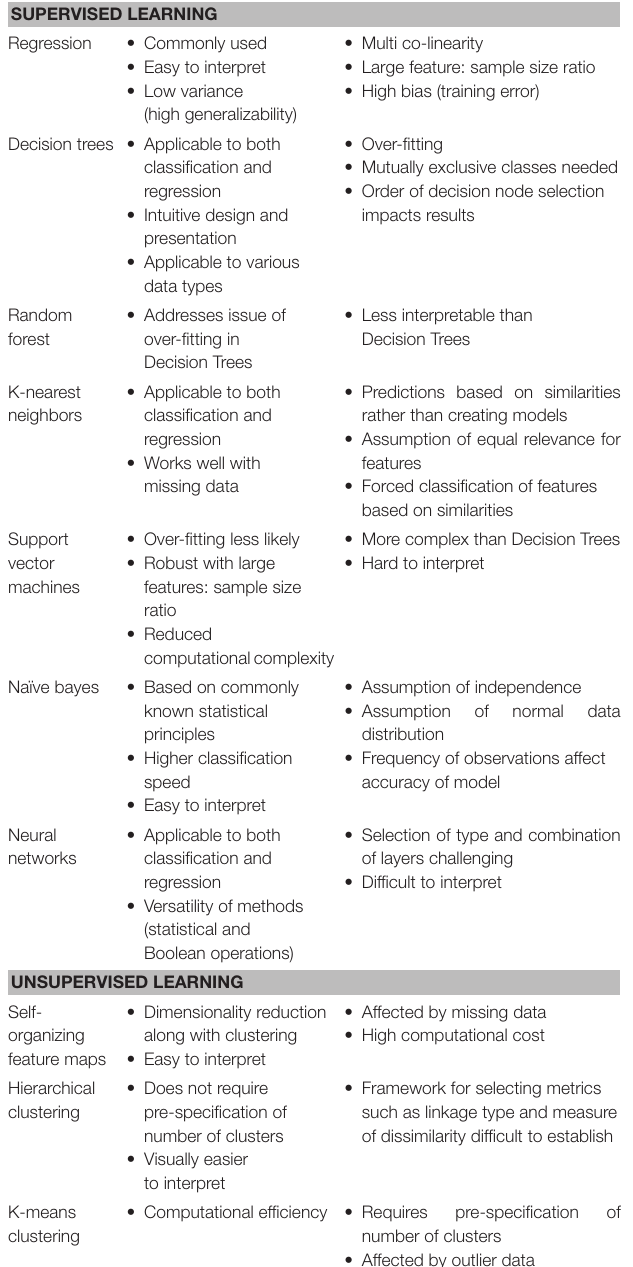
TABLE 1 | Comparison of current analytical methods utilized in data-driven research with potential for application to DLGG research. Method